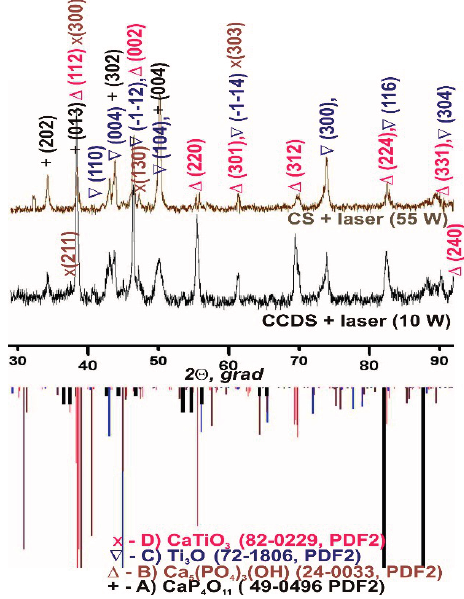
Figure 7. Comparative X-ray phase analysis of the CCDS and CS after laser